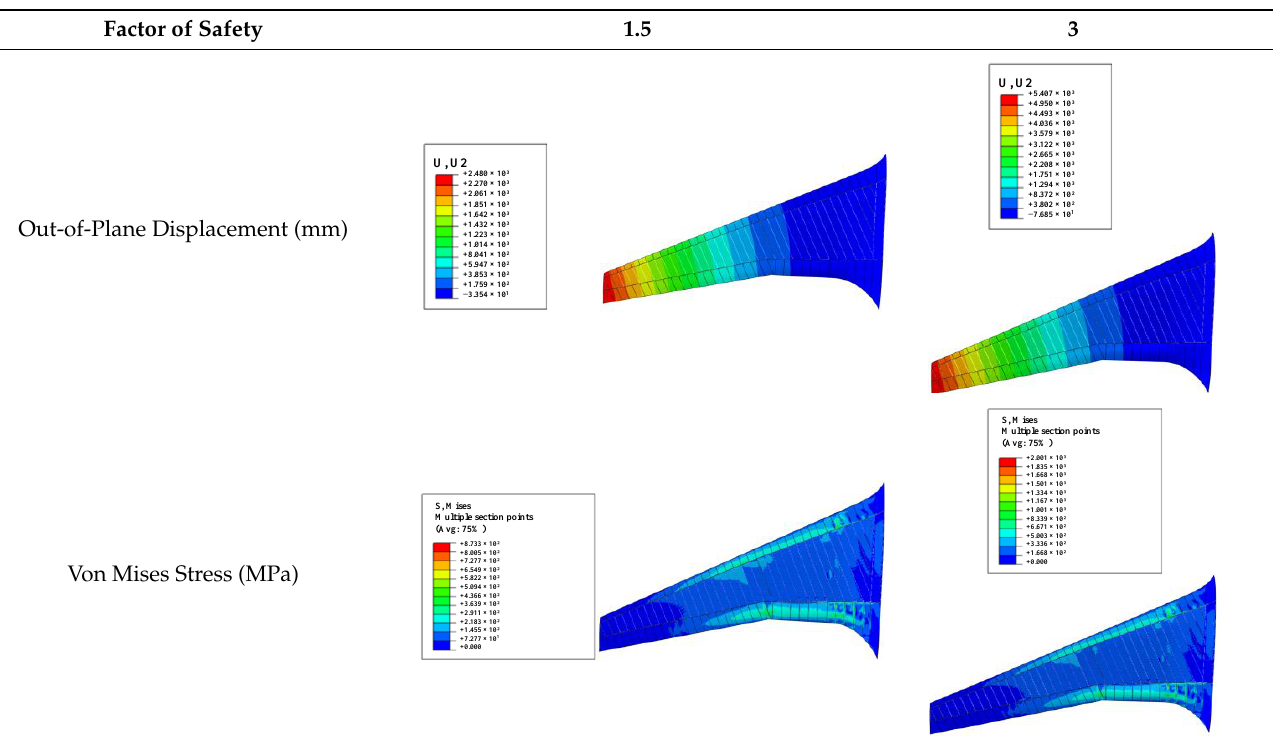
Table 4. Results of out-of-plane displacement, stress, strain, and fiber tensile failure criterion of undamaged BWB wing at different values of F.o.S.